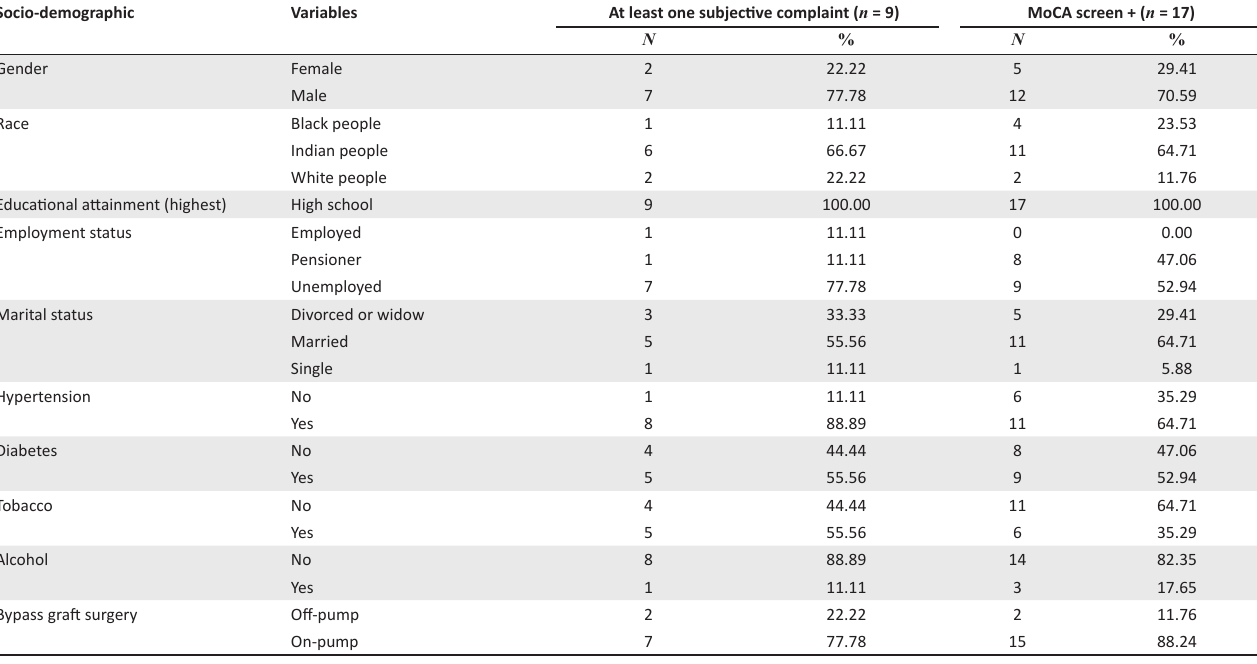
TABLE 4: Socio-demographic and clinical profile distribution by subjective and objective cognition risk status. Socio-demographic